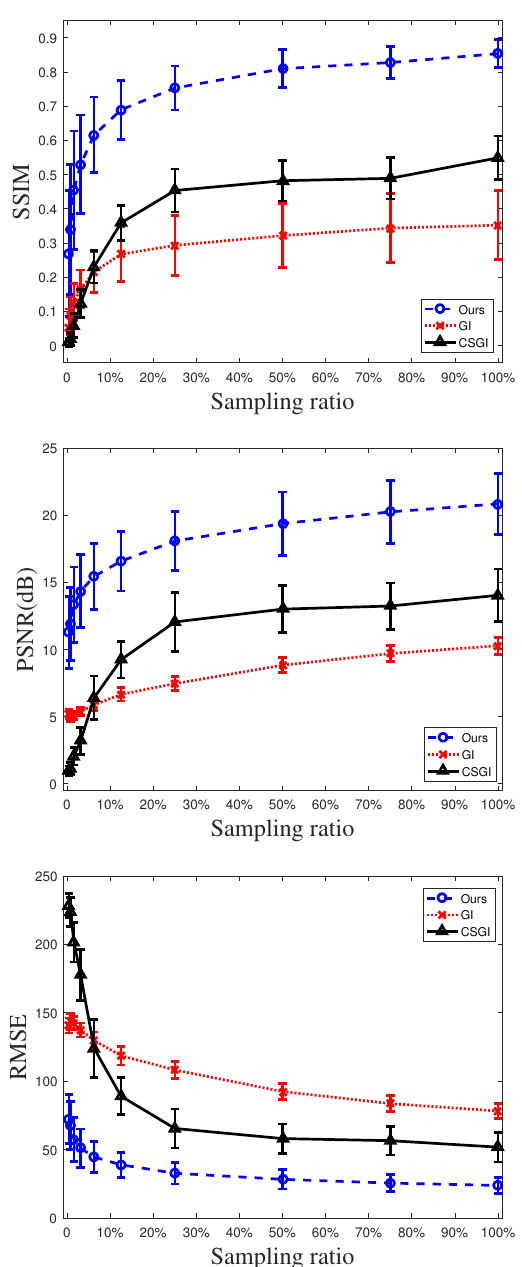
Figure 6. Quantiative evaluation of CGI, CSCGI, and our scheme (labeled as OURS) in the simulation with a sampling ratio of β = W · H N